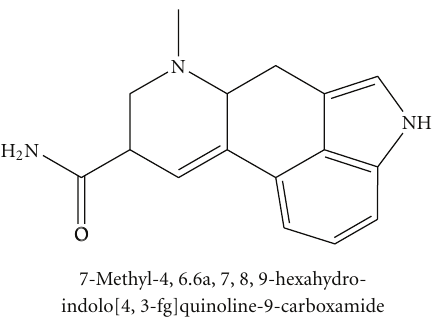
Figure 2: Structure of lysergic